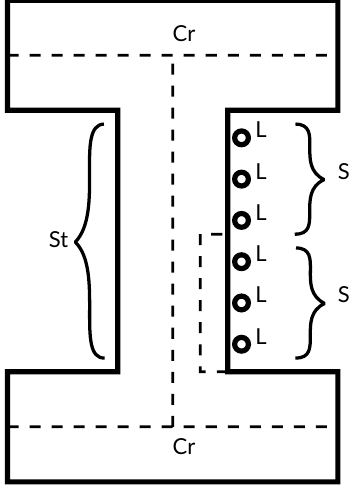
Figure 5. Schematic representation of a lighting